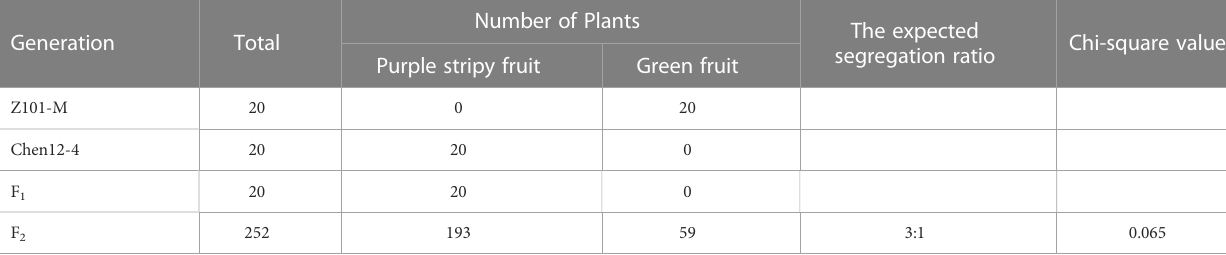
TABLE 1 Genetic analysis of the purple stripy trait in the segregation